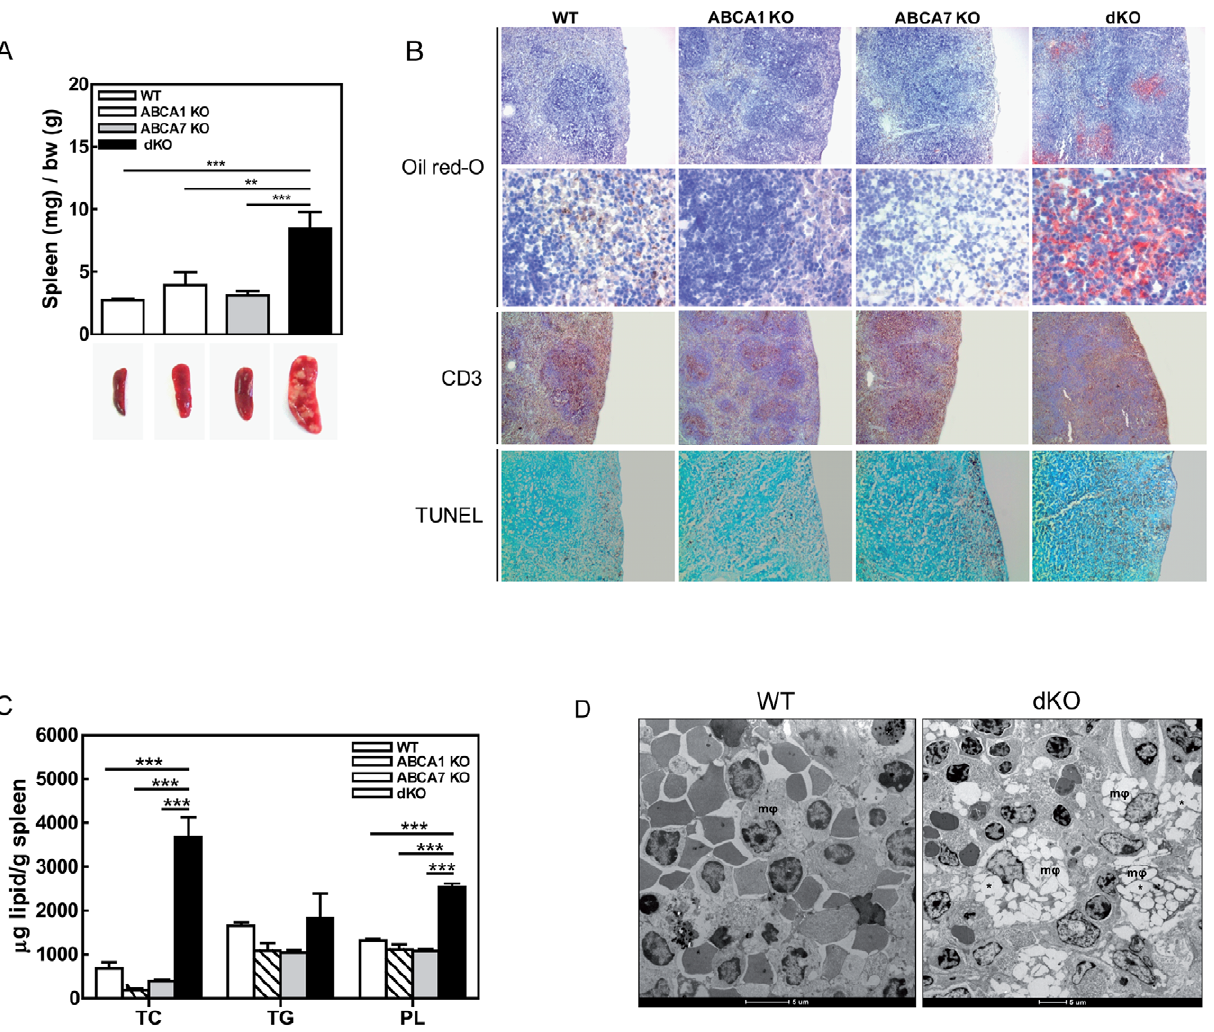
Figure 6. Effects of single macrophage ABCA7 and combined macrophage ABCA1 and ABCA7 deficiency on spleen. ( A ) Relative spleen weights of transplanted mice to body weight (bw) and representative images are shown. ( B ) Cryosections of spleens from all groups of mice were stained for lipid accumulation using Oil-red O staining (original magnification 6 50 for first row and 6 400 for second row), against lymphocyte CD3 antigen by immunohistochemistry (original magnification 6 40) and for apoptosis using TUNEL staining (original magnification 6 40). ( C ) Lipids were extracted from spleens with organic solvents. Values represent the mean 6 SEM of $ 9 mice per group. Statistically significant difference **p , 0.01 and ***p , 0.001. ( D ) Electron microscopic images of spleens from WT and dKO mice. Macrophages (m w ) of dKO transplanted mice exhibited massive cytoplasmic lipid accumulation (*).